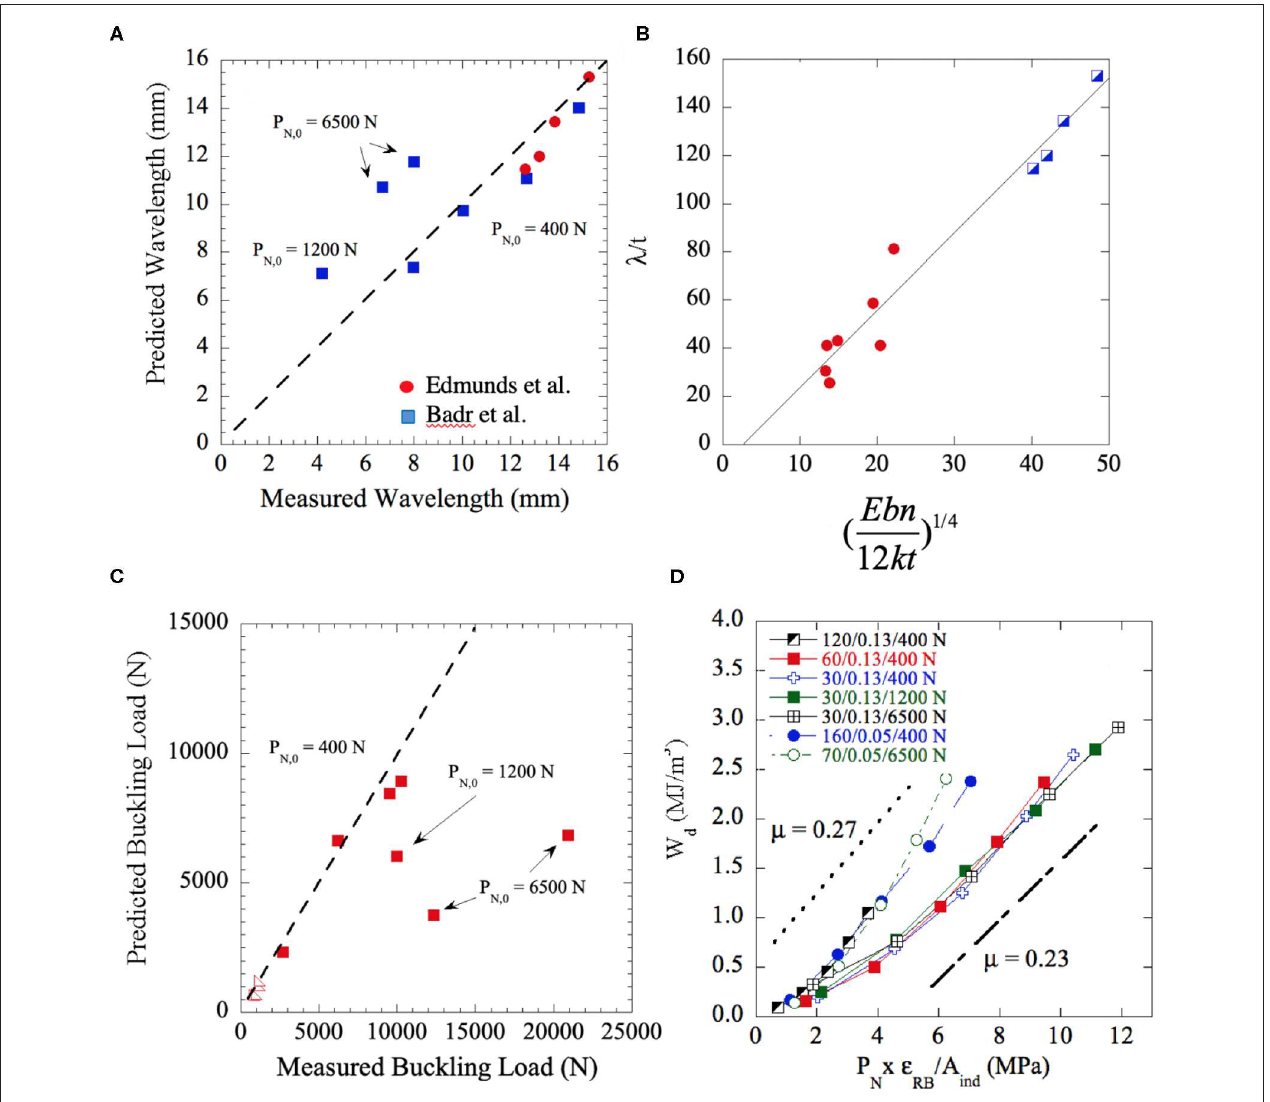
FIGURE 5 | (A) Comparison of measured and predicted wavelengths, λ , (B) λ /t vs. (Ebn/12kt) 1 / 4 , (C) Comparison of measured and predicted buckling loads. (D) Plot of W d vs. (P N ε RB /A ind ). Slope of these lines is proportional to the friction coefficient, µ (Badr et al.,